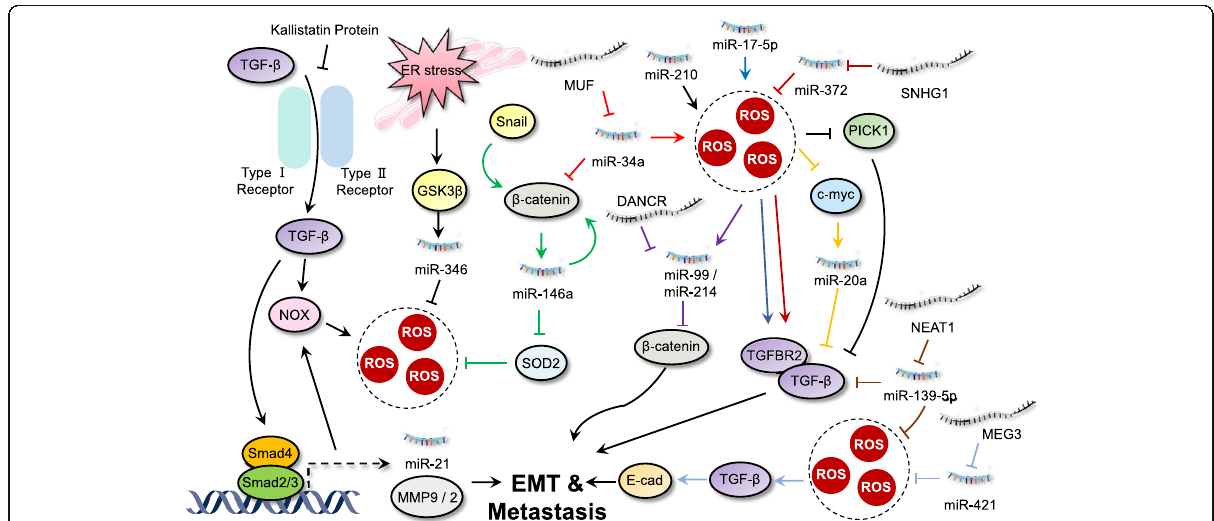
Fig. 6 Interplay between ROS and ncRNAs in regulating invasion and metastasis. The interaction between ncRNAs and ROS indicates a crucial role for both positive or negative regulation of Wnt and TGF- β pathways to modulate invasion and metastasis of cancer